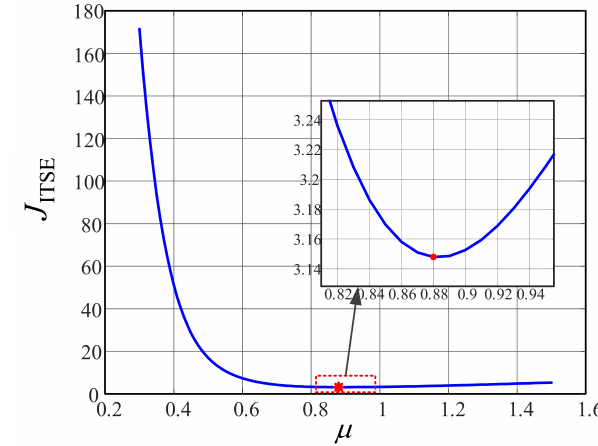
Figure 7. J ITSE corresponding to the µ